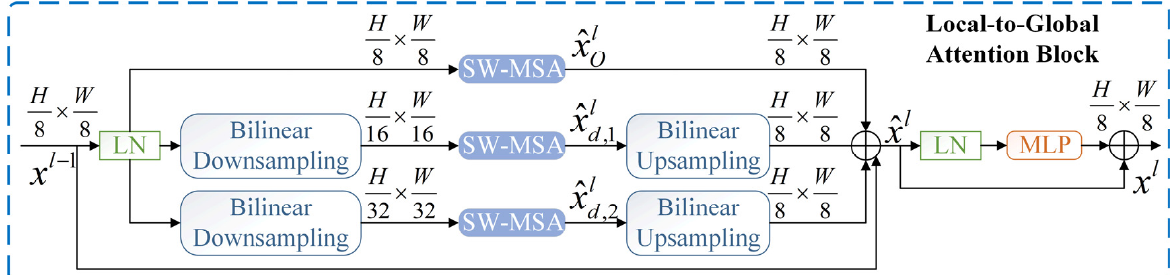
Figure 5. The local-to-global attention block. Positional encoding is a mechanism for adding positional information in images to self-attention operations. Classical positional encoding mechanisms are conditional positional encoding (CPE), relative positional encoding (RPE), and absolute positional encoding (APE). However, the recently proposed LePE mechanism leads to better results for image classification. The difference between these positional coding mechanisms shows in Figure 6. APE and CPE attach positional information into the feature maps before entering the Swin Transformer blocks, while RPE and LePE integrate that within each Swin Transformer block. RPE introduces the positional information into the self-attention calculation, while LePE processes V directly. The formula of self-attention computation with the LePE mechanism is given below: